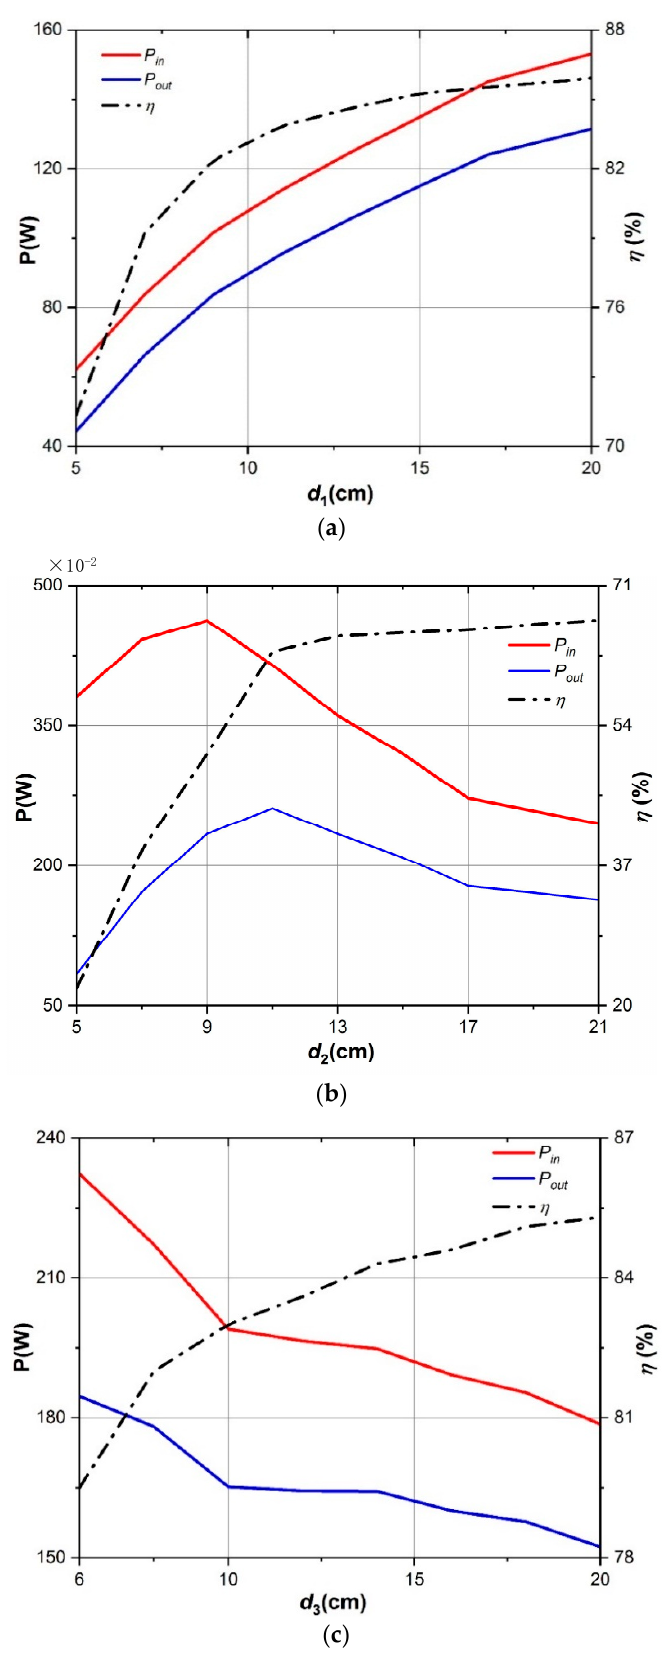
Figure 19. Power transfer and efficiency versus the distance when iron plate is placed along ( a ) line l 1 ; ( b ) line l 2 ; and ( c ) line l 3 .